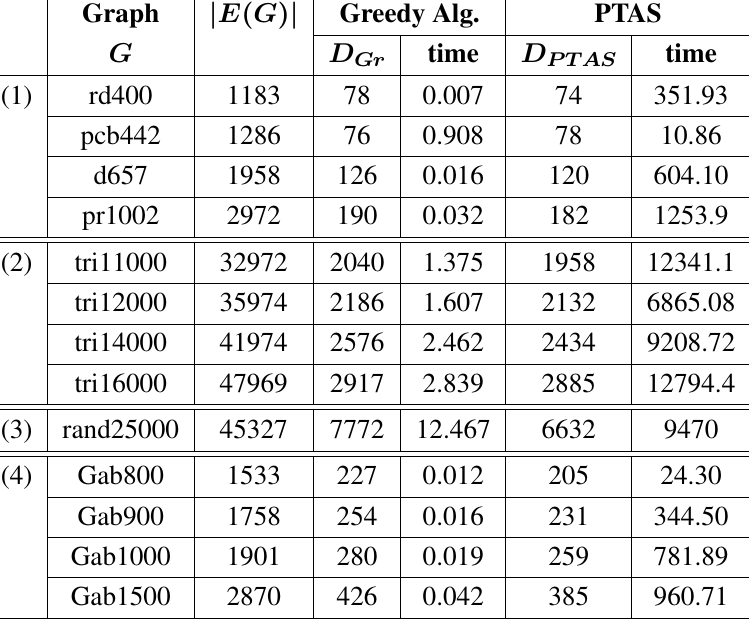
Table 4. Computational results for Greedy and PTAS for large instances (time in